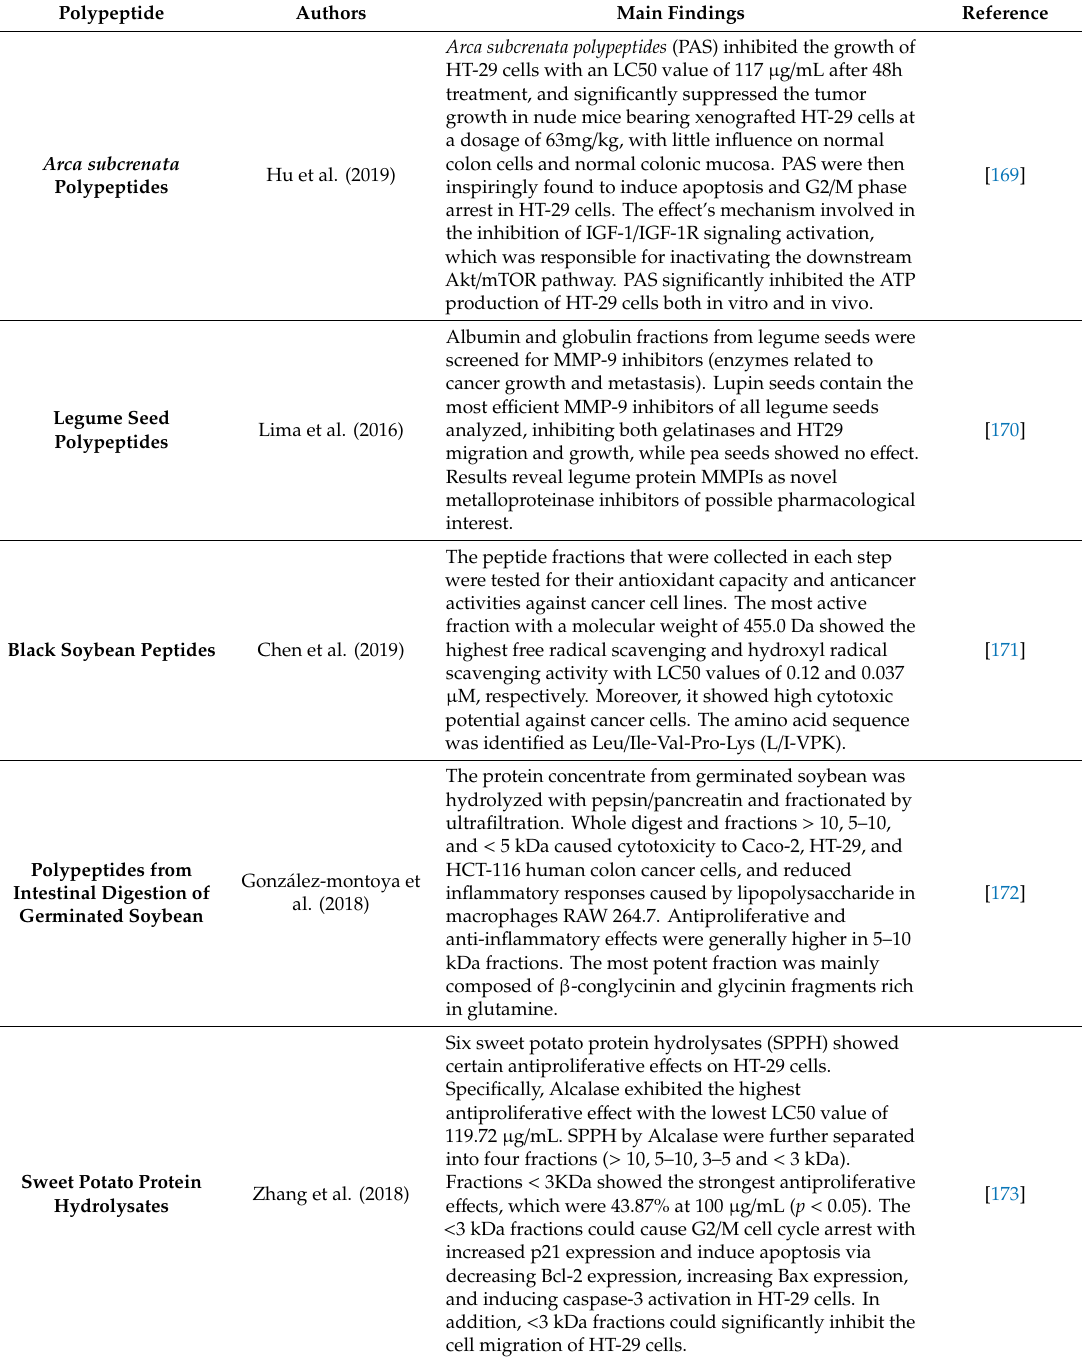
Table 3. Recent advances in polypeptides (PPD) with antioxidant e ff ects for